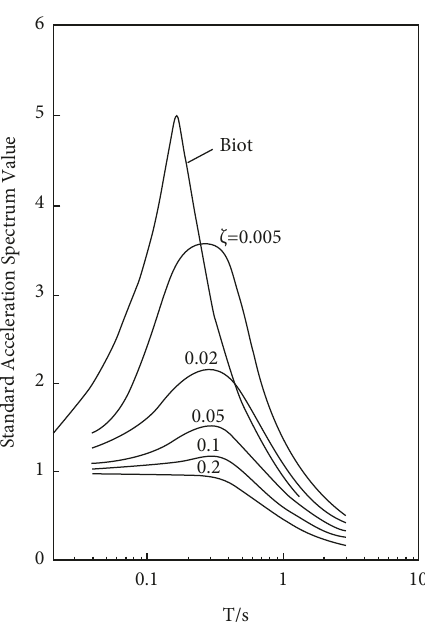
Figure 1: Comparison of the Biot standard spectrum and the Housner design